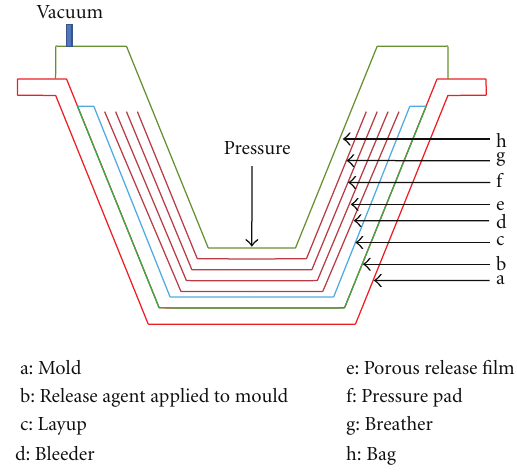
Figure 1: Typical Autoclave-molding bagging scheme.